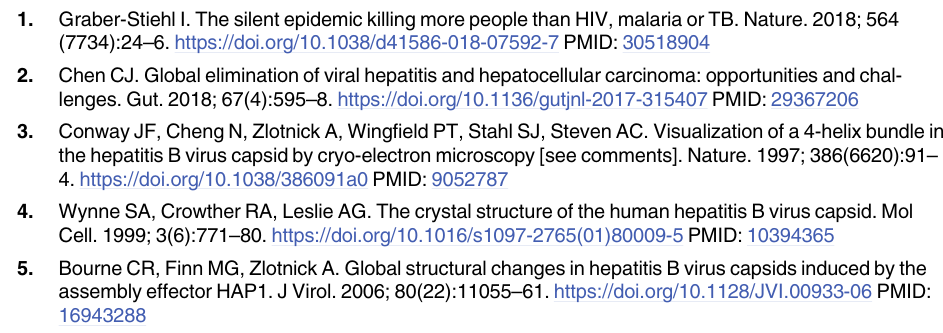
S7 Table. PISA intra-dimer interface analysis of T = 3 and T = 4